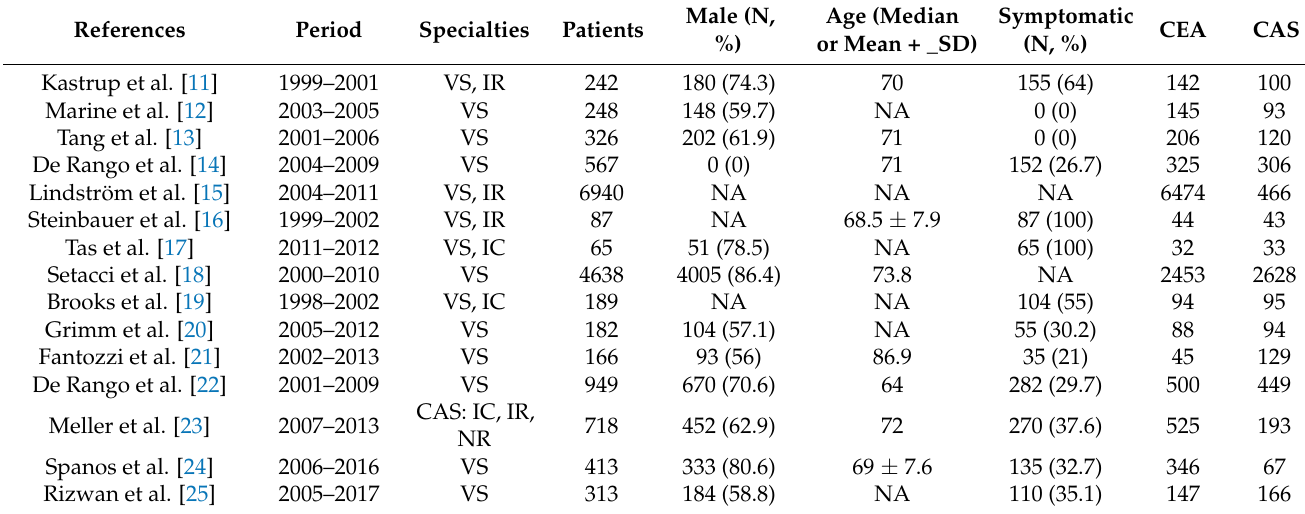
Table 1. The studies’ characteristics.